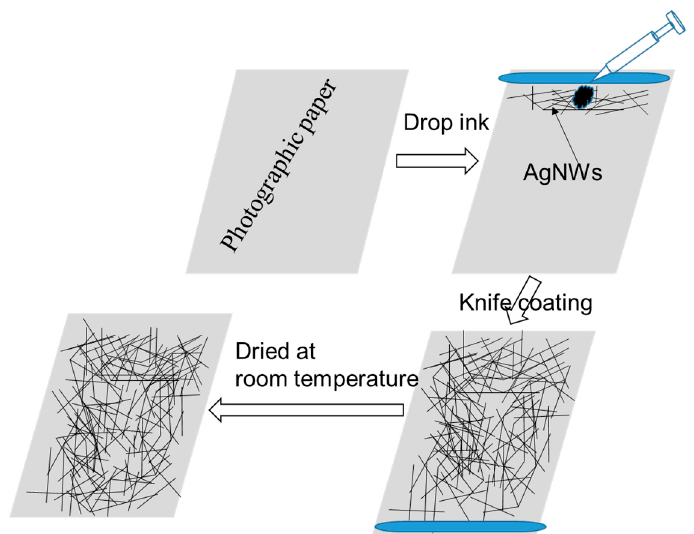
Figure 3. Schematic diagram for the steps applied to fabricate the AgNW coating.